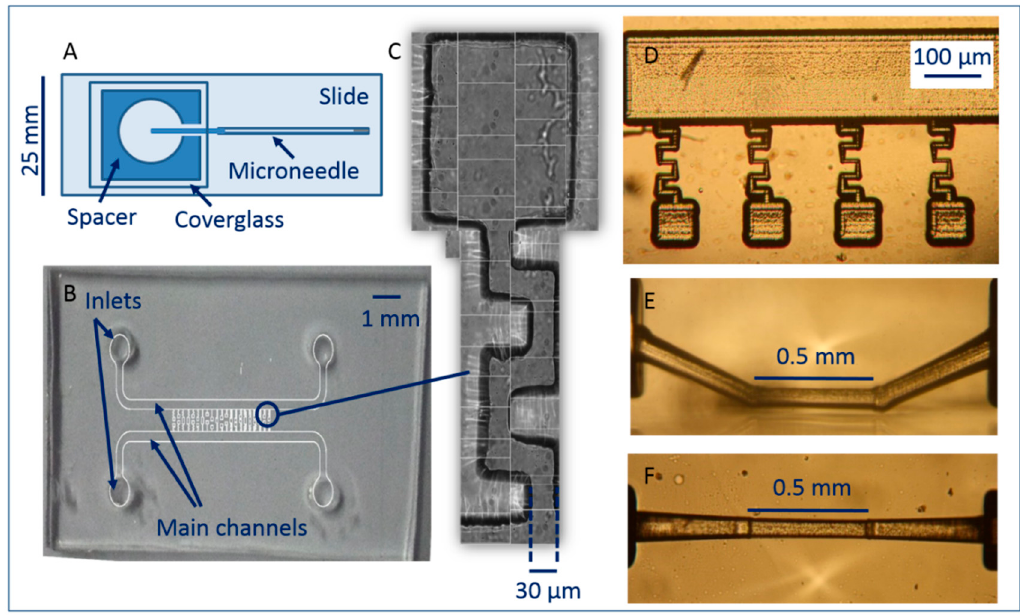
Figure 3. Chip designs. ( A ) Pulled micropipette-based chip; ( B ) PDMS chip; ( C ) channel and isolation chamber in PDMS chip; ( D ) ULI and chemically etched chip with channels on the surface of fused silica; ( E ) ULI and chemically etched sub-surface channel in fused silica, side view; ( F ) ULI and chemically etched sub-surface channel in fused silica, top view.